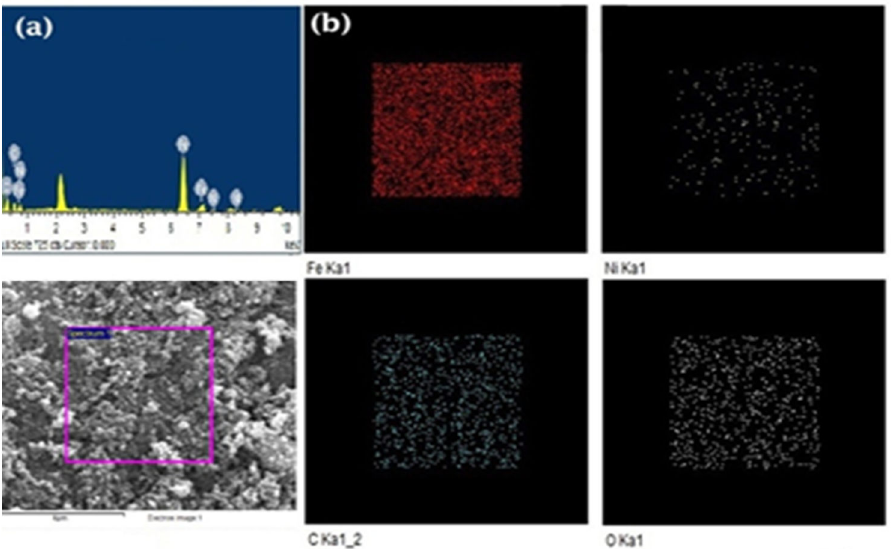
Fig. 3. (a) EDS spectrum of Ni/Fe nanoparticles on AC (vacuum, 5 × 10 -7 torr; lens current, 1.8 A; voltage, 20 kV), (b) EDS elemental mapping of the Ni/Fe nanoparticles on AC